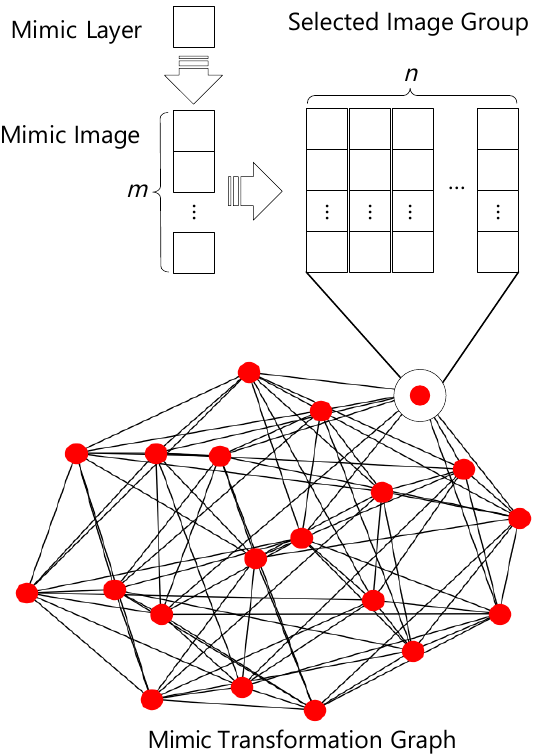
Figure 4. The illustration of mimic transformation graph components. The mimic transformation graph (MTG) represents the transformation relationship between SIGs, denoted as W = ( N , E ) , where N is a set of SIG defined as above, and E ⊆ N × N is a set of edges, where each edge indicates the relationship between mimic